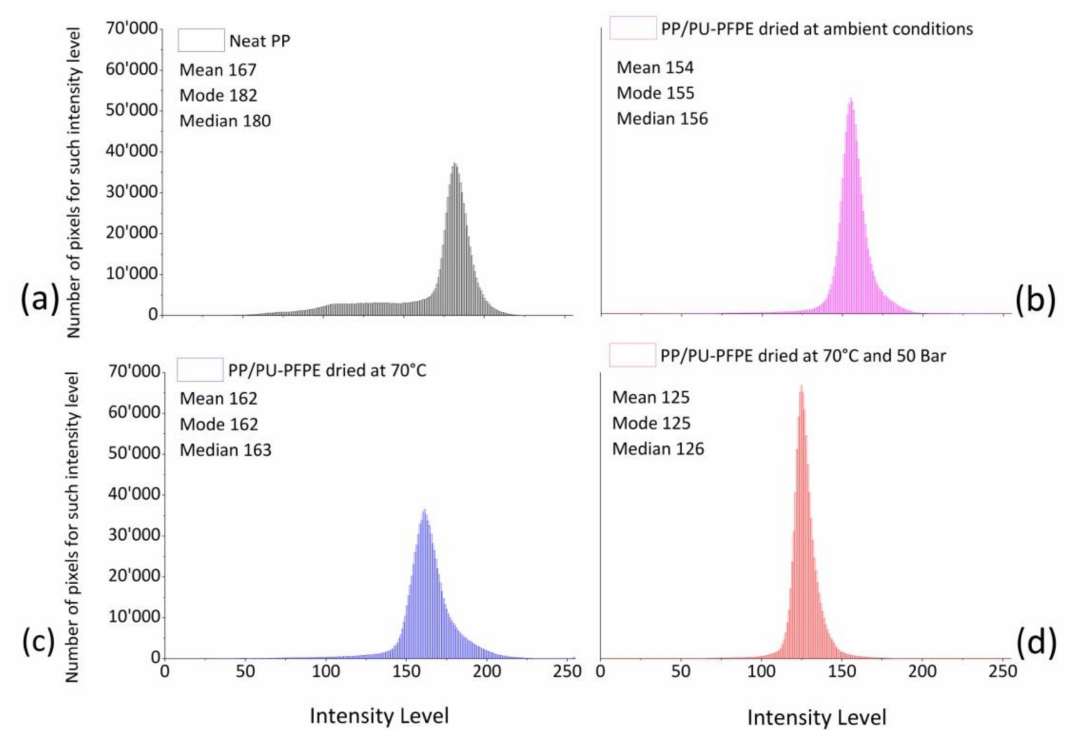
Figure 11. Histograms of gray imagines by SEM micrographs for neat PP ( a ), and PP/PU-PFPE dried at ambient conditions ( b ), dried at 70 ◦ C ( c ), or at 70 ◦ C and 5 × 10 6 Pa ( d